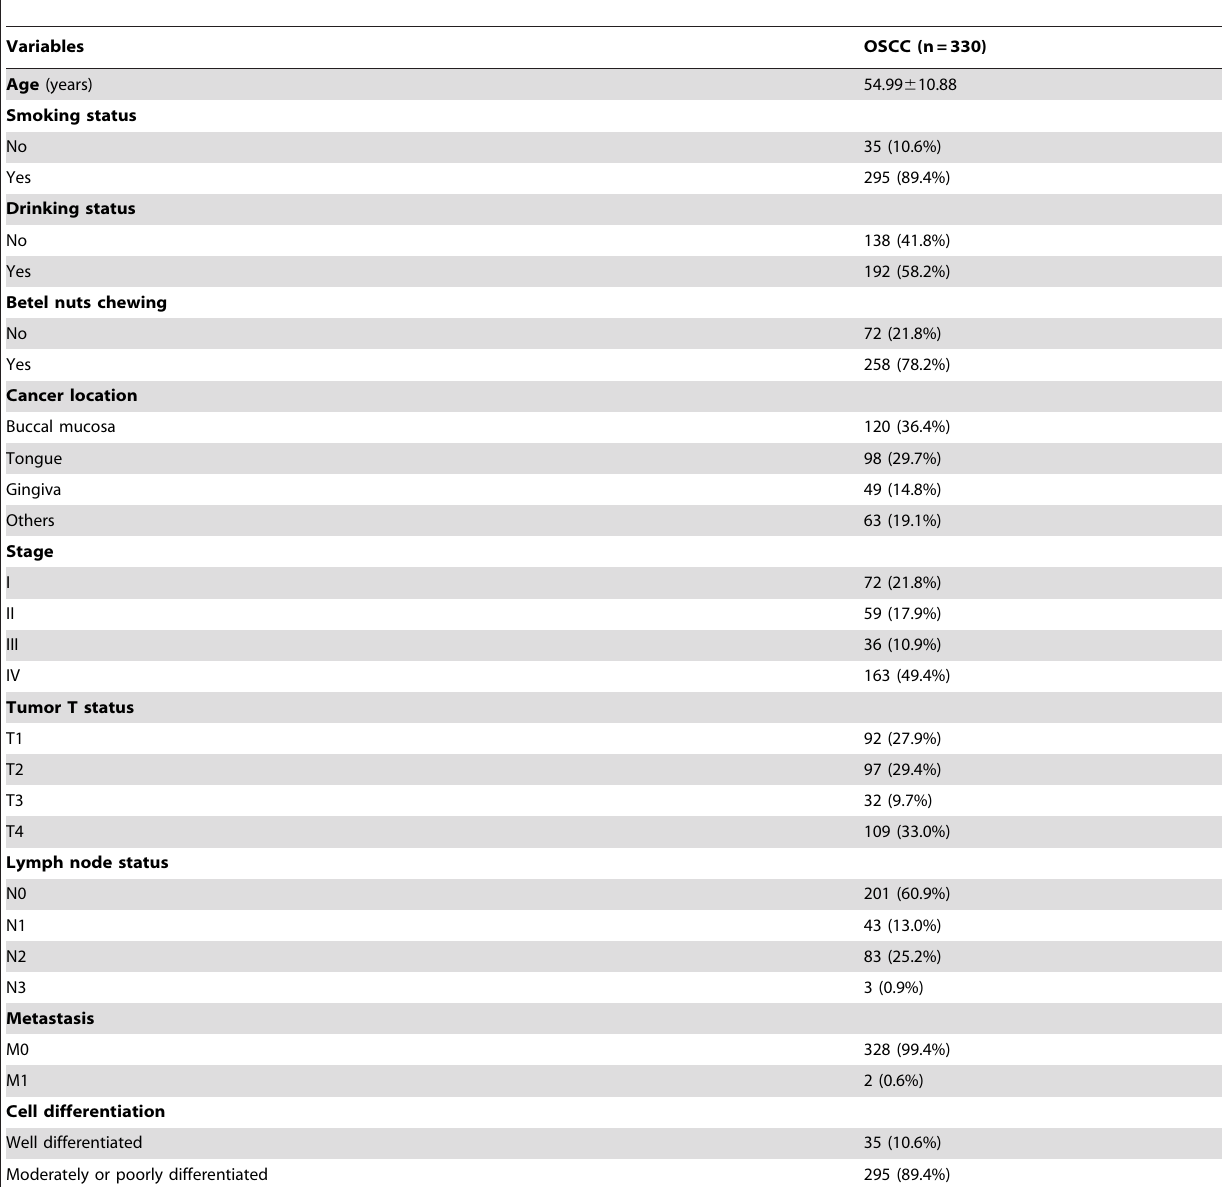
Table 1. Demographic characteristics and clinical features of OSCC